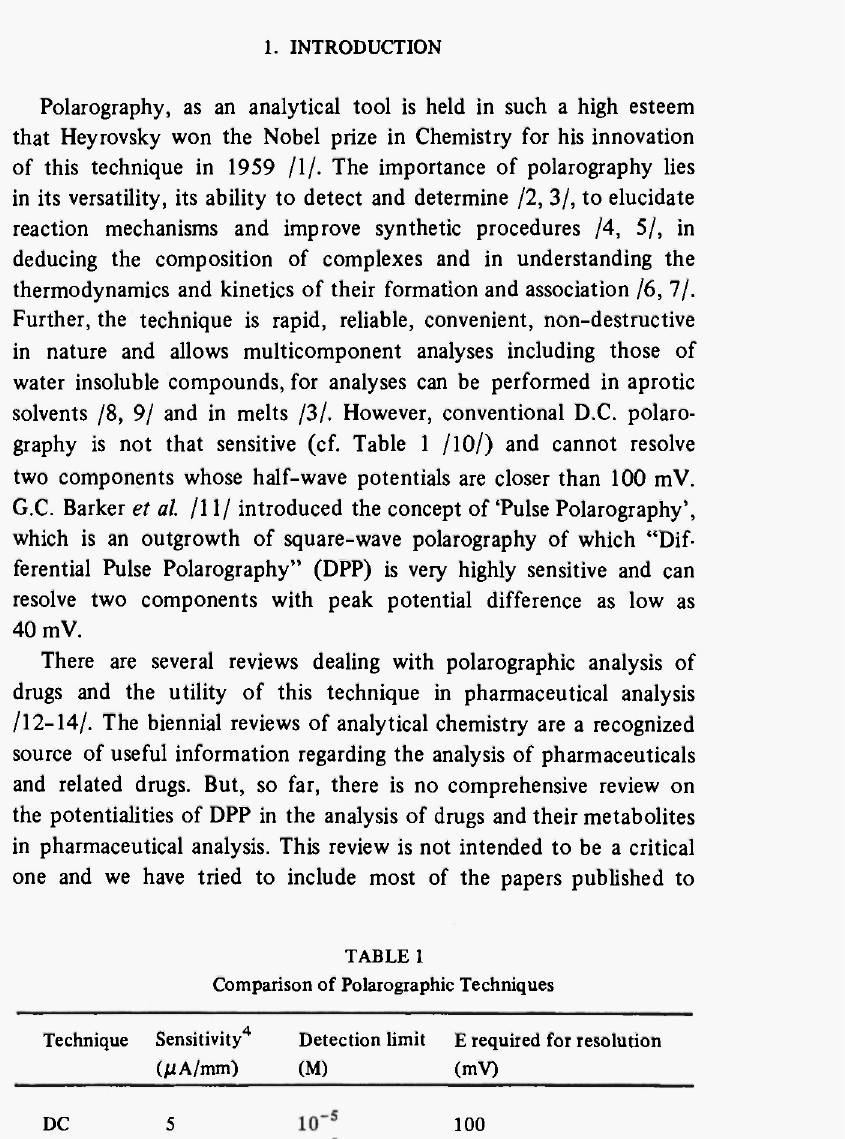
Comparison of Polarographie